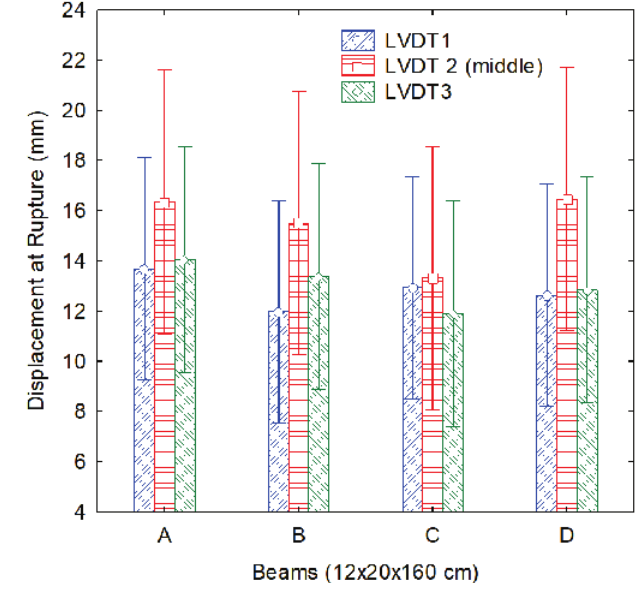
Analysis of load results at rupture – beams (12 × 20 × 160 cm)